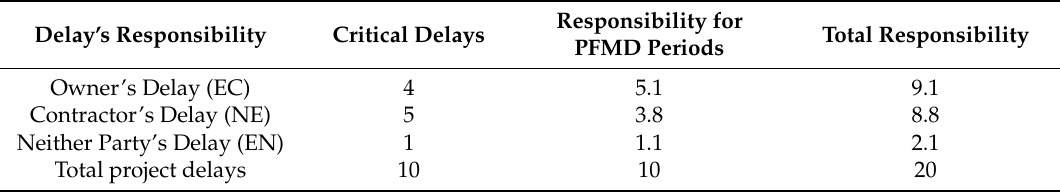
Table 11. The final responsibility of project delay analysis by the proposed